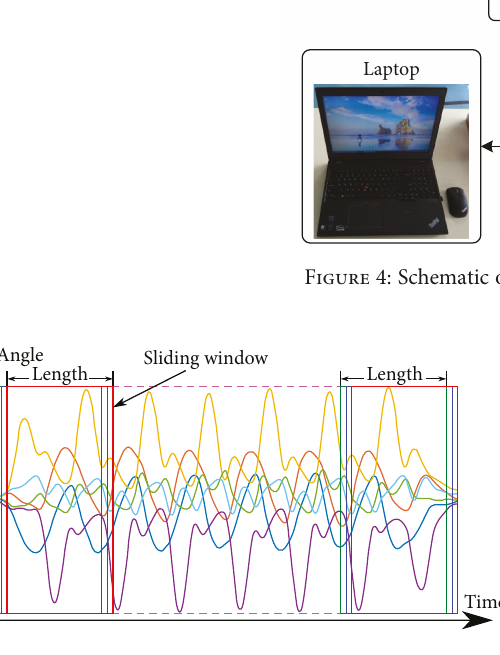
Figure 5: Sliding window method for splitting gait data.